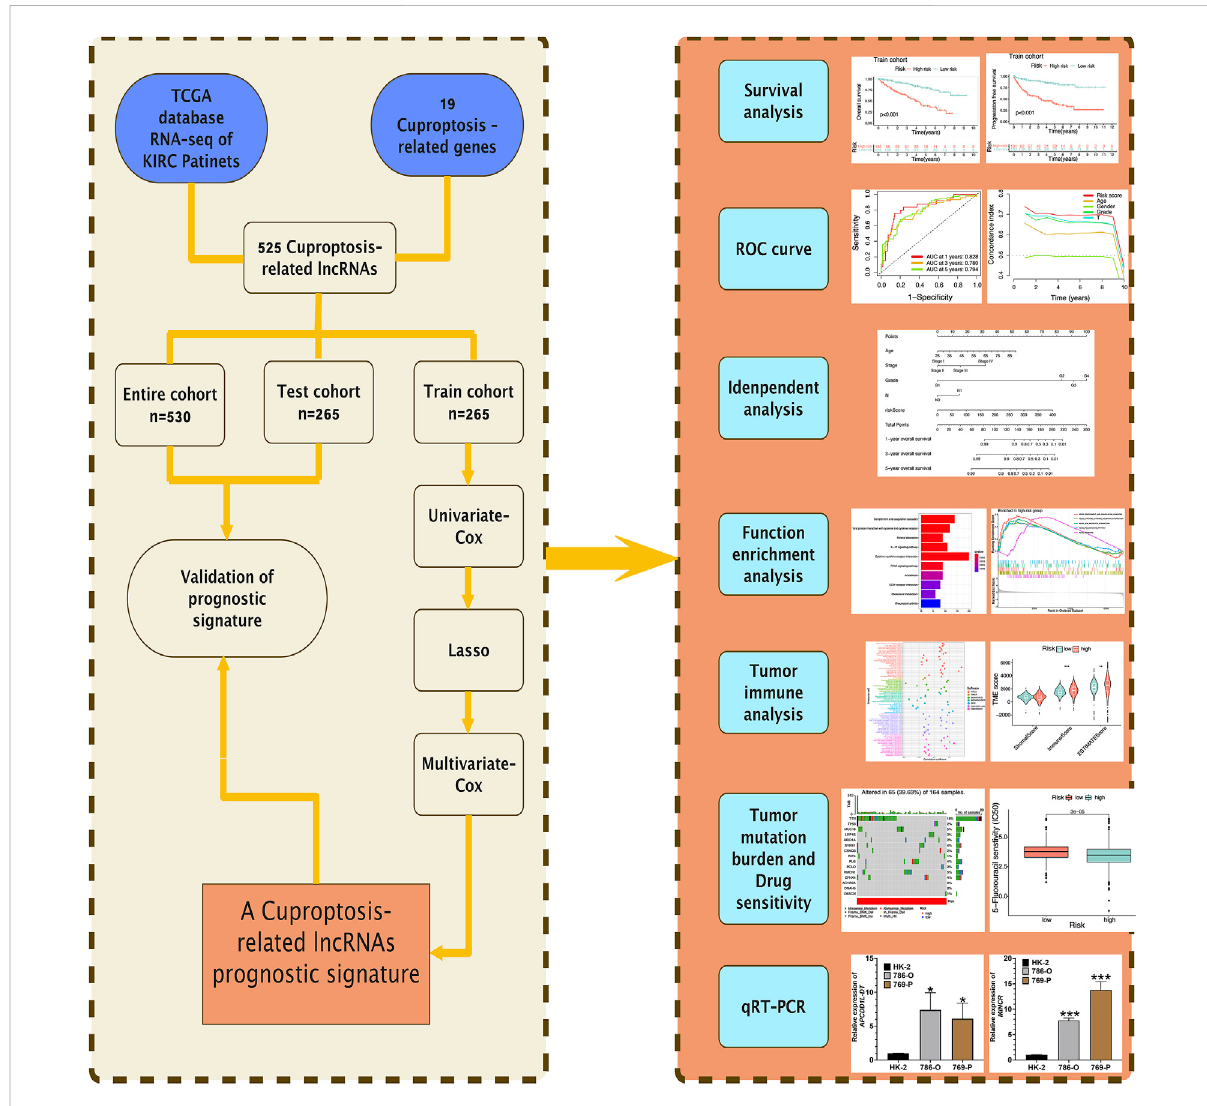
FIGURE 1 The research steps of this